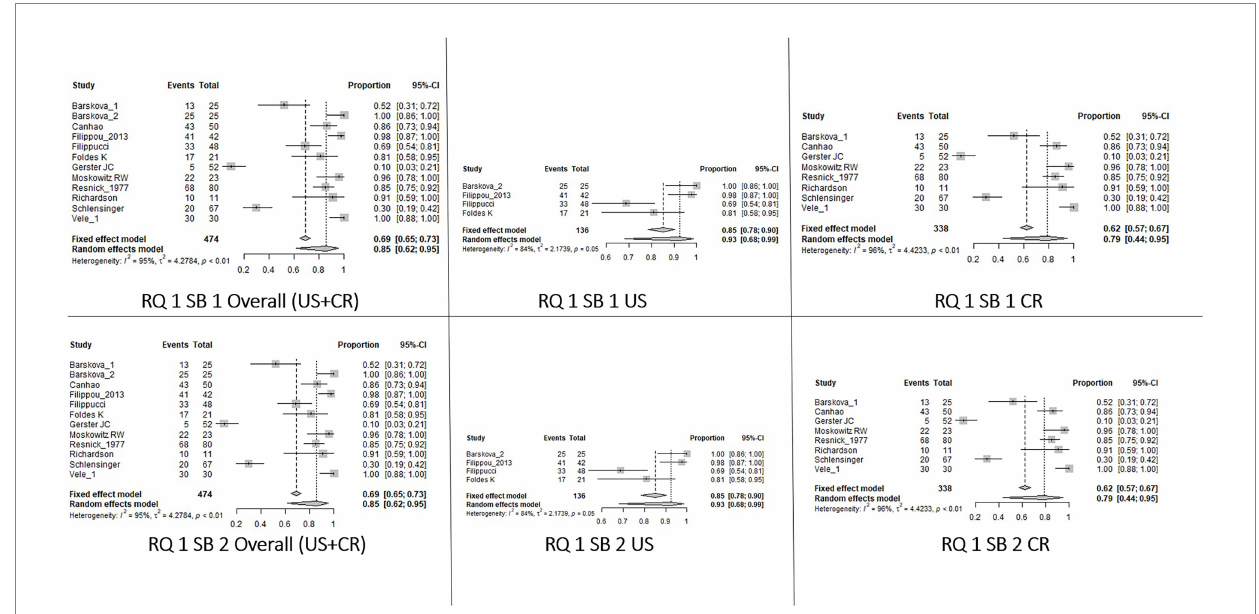
FIGURE 2 Forest Plot Knee, Research question 1 (RQ1), Sub_analysis 1 and 2: patients with definite diagnosis of CPPD and knee as index joint (SB_1) or knee and/ or wrist (SB2) analyzed by